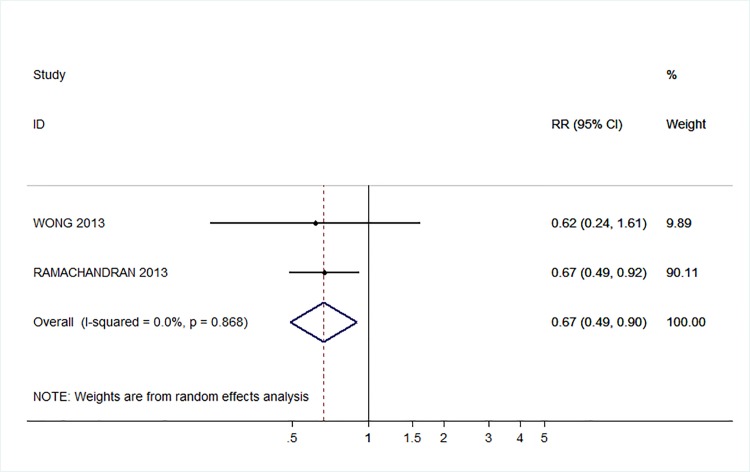
Physical activity and diet interventions using SMS function–cumulative incidence of diabetes.